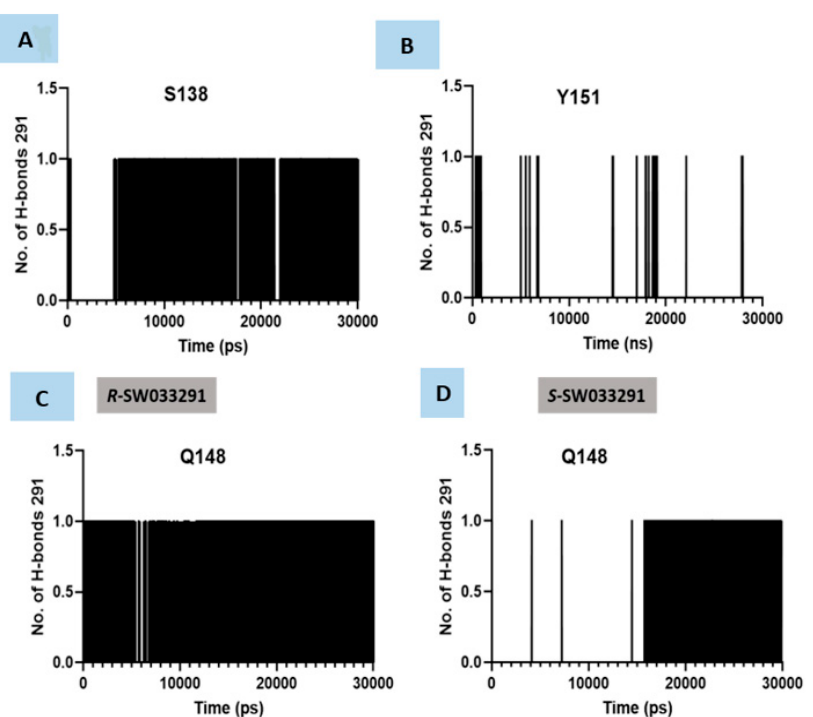
Figure 4. Ser138 consistently exhibits hydrogen bond interactions with ( R )-SW033291 relative to Tyr151. Moreover, hydrogen-bond interactions with Gln148 are more prevalent in ( R )-SW033291 vs. ( S )-SW033291 across the 30 ns MD simulations. ( A ). Hydrogen bonding interactions of oxygen (O6) of sulfoxide ( R )-X-SW033291 with side chain of Ser138 across the 30 ns MD simulations. ( B ). Hydrogen bonding interactions of oxygen (O6) of sulfoxide ( R )-S(O)-SW033291 with Tyr151 side chain across the 30 ns MD simulations. ( C ). Hydrogen bond interactions of ( R )-S(O)-SW033291 amino group with Q148 and ( D ). Hydrogen bond interactions of ( S )-S(O)-SW033291 amino group with Q148.